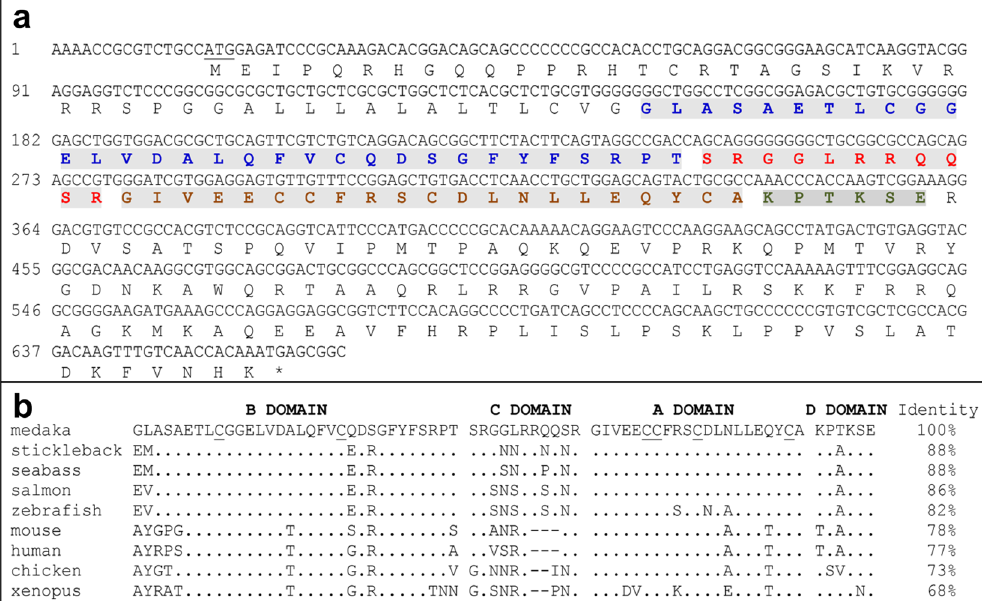
Figure 1. Nucleotides and predicted amino acid sequence alignment of medaka IGF2. ( a ) Nucleotides and predicted domains of medaka IGF2. Nucleotides are numbered to the left. Translated amino acids are shown below the DNA sequence. Mature peptide consisting B, C, A and D domains are distinguished with blue, red, brown and cyan in shadowed letters respectively. Signal peptide locates before mature peptide and E domain is after D domain. ( b ) Sequence alignment of IGF2 mature peptides. Identical positions are indicated as dots, and gaps (dashes) are introduced to optimize alignment. Six conserved cysteine residues are underlined. Accession numbers of the IGF2 sequences are ENSGACP00000014712 for stickleback ( Gasterosteus aculeatus) , AAB64195.1 for seabass ( Lates calcarifer) , CAA65862.1 for salmon ( Oncorhynchus keta ), NP_001001815.1 for zebrafish ( Danio rerio ), NP_034644.1 for mouse ( Mus musculus ), NP_001121070.1 for human ( Homo sapiens ), NP_001025513.1 for chicken ( Gallus gallus ) and NP_001082128.1 for xenopus ( Xenopus laevis